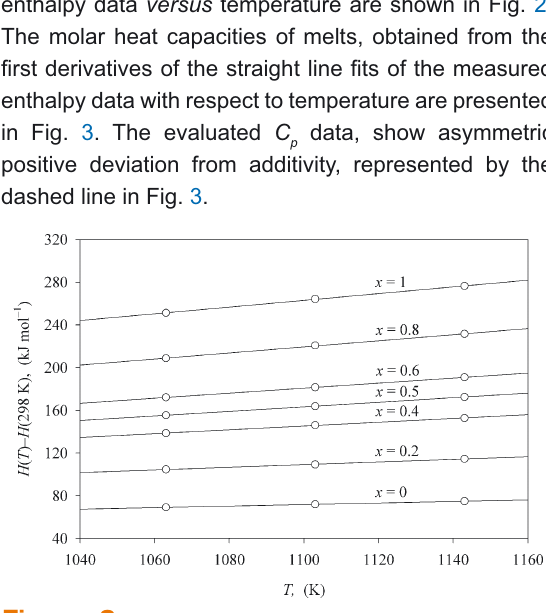
Figure 2. Temperature dependences of the relative enthalpy of